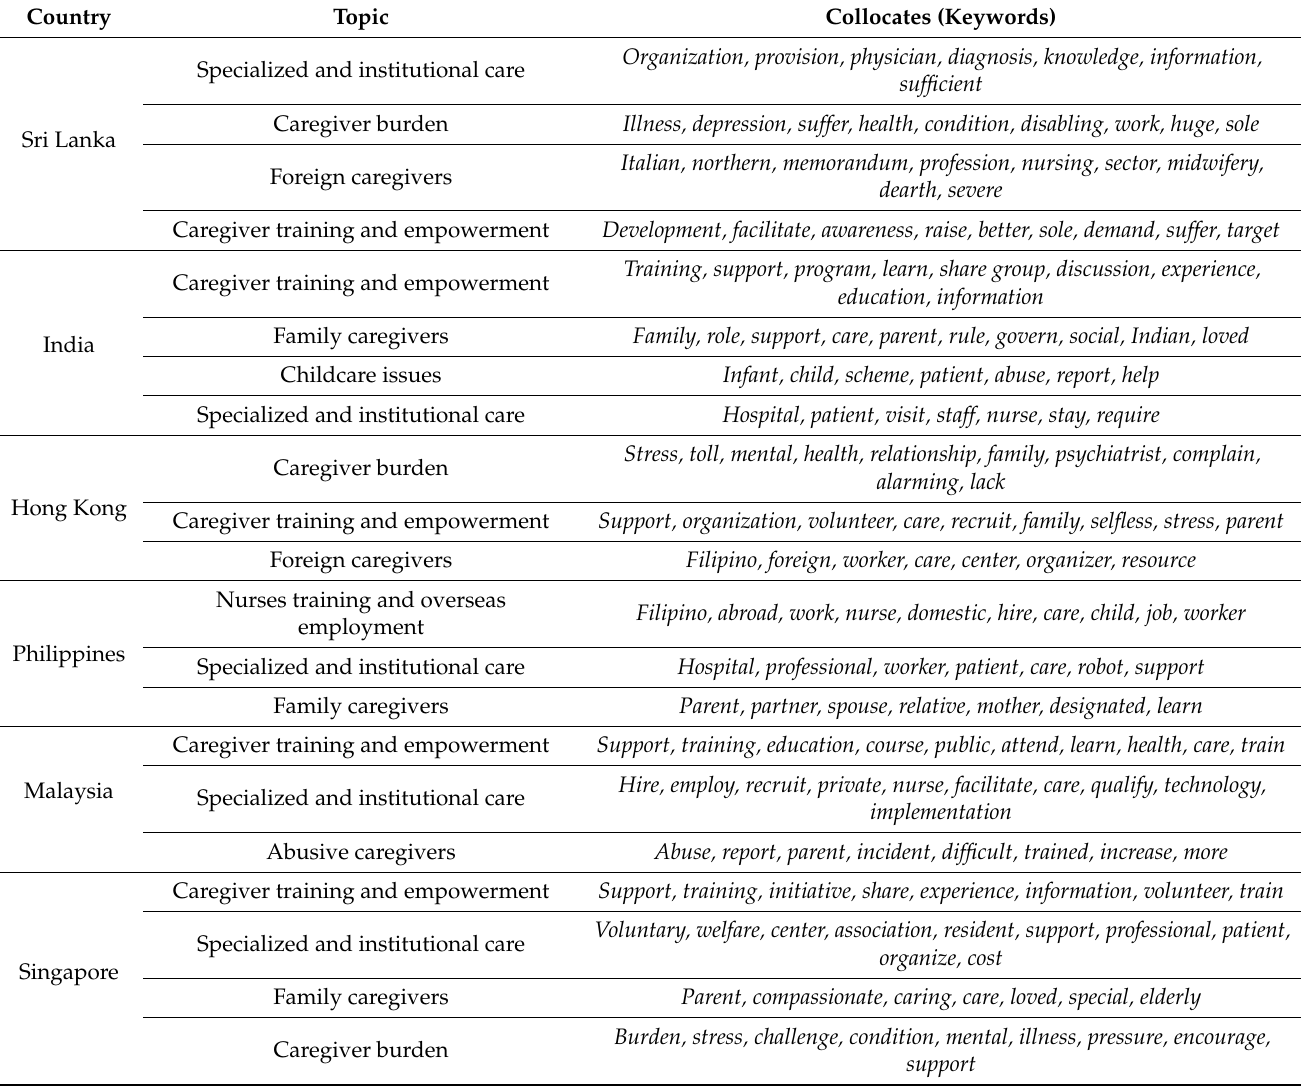
Table 1. Topics and associated keywords of societal narratives on caregivers across six Asian countries/cities. Country Topic Collocates